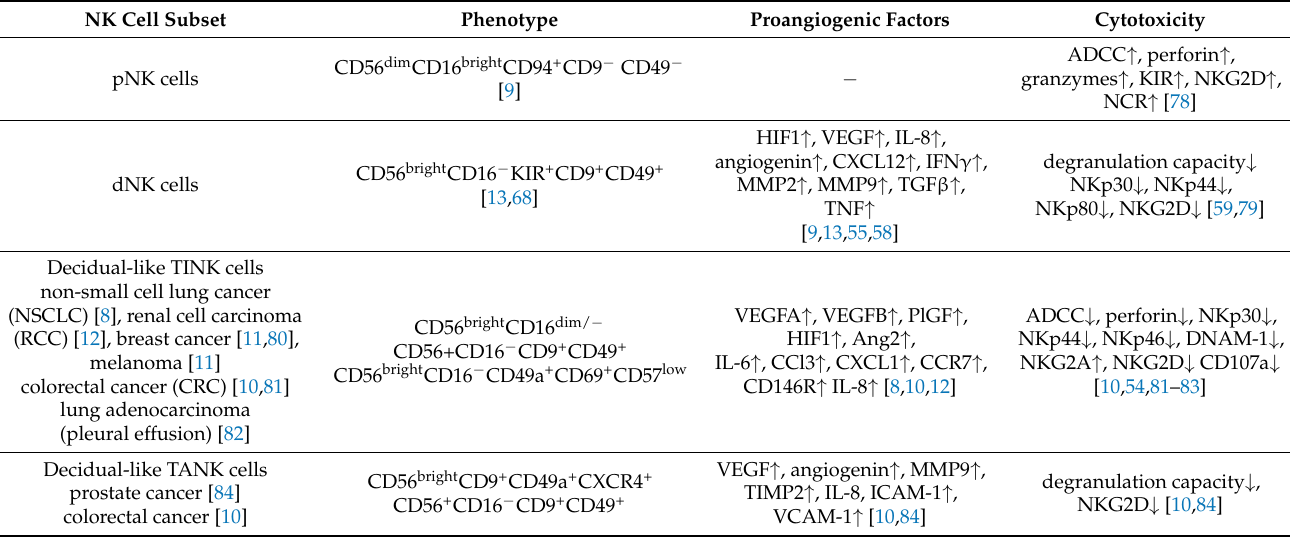
Table 1. Comparison of the dominant peripheral blood NK (pNK) cell subset, decidual NK (dNK) cells, decidual-like tumor-infiltrating and tumor-associated NK (TINK, TANK, respectively) cells, in terms of the phenotype, angiogenic activity, and